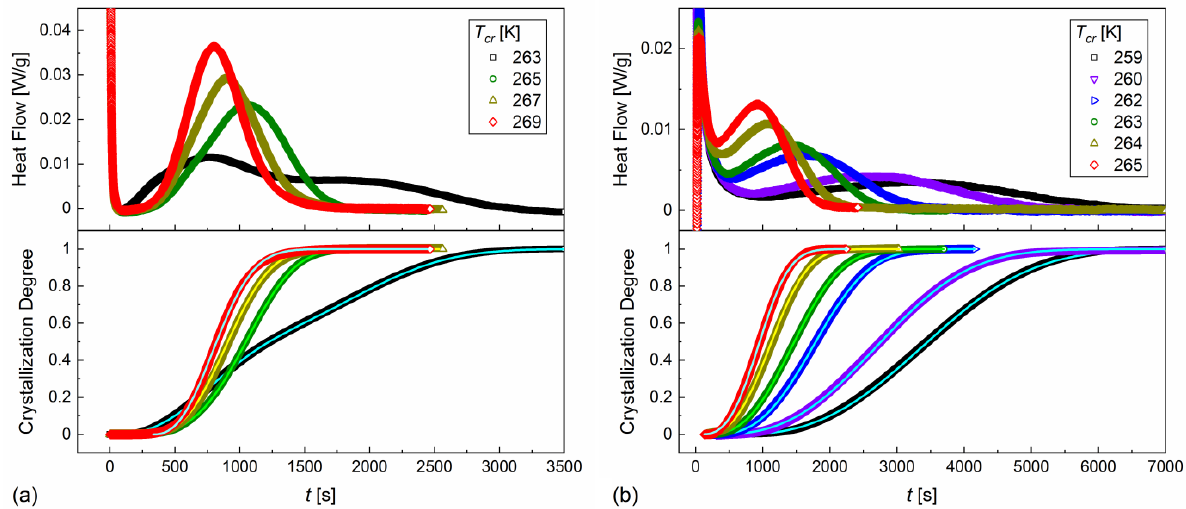
Figure 6. DSC curves collected during the isothermal melt crystallization ( a ) and cold crystallization ( b ) of 7HH6 ( upper panels) and crystallization degree vs. time ( bottom panels). The lines are the fitting results of the Avrami model. Table 2. Parameters of the Avrami model describing the kinetics of crystallization of 7HH6.